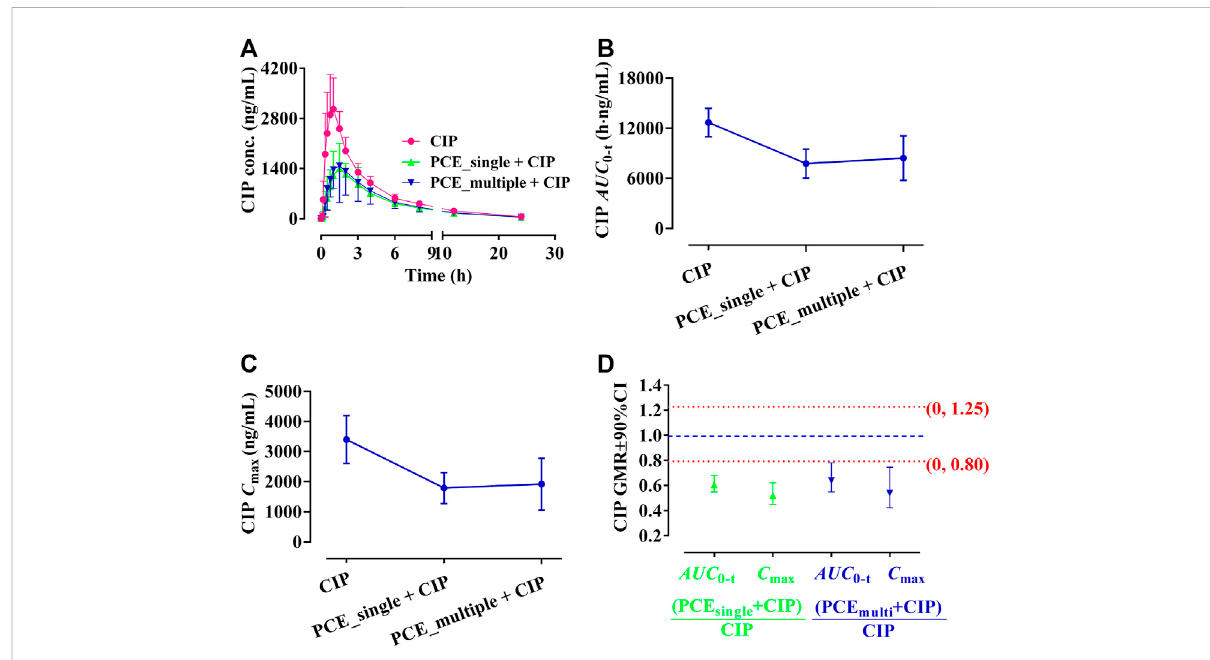
FIGURE 2 Plasma cipro fl oxacin (CIP) concentration-time pro fi les (A) , the systemic exposure parameters includi ng AUC 0-t (B) and C max (C) , a nd their 90% CIs for the geometric mean ratios [GMR, (D) ] in the presence and absence of the single-dose/multiple-dose PCE to healthy humans (mean ± SD, n = 12).